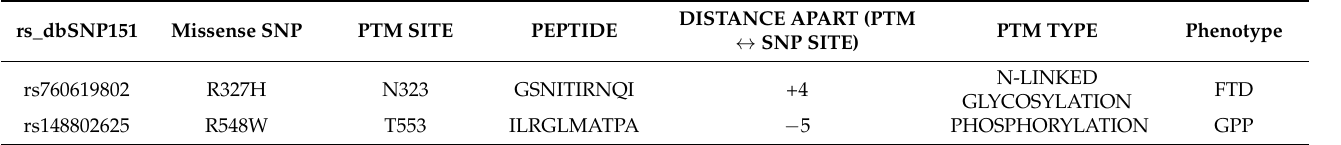
Table 3. Disease-associated PTM-SNPs on the MPO